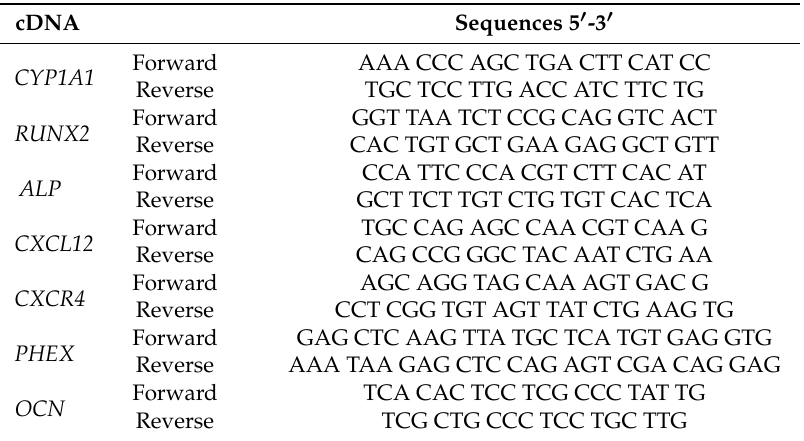
Table 1. Primer sets for